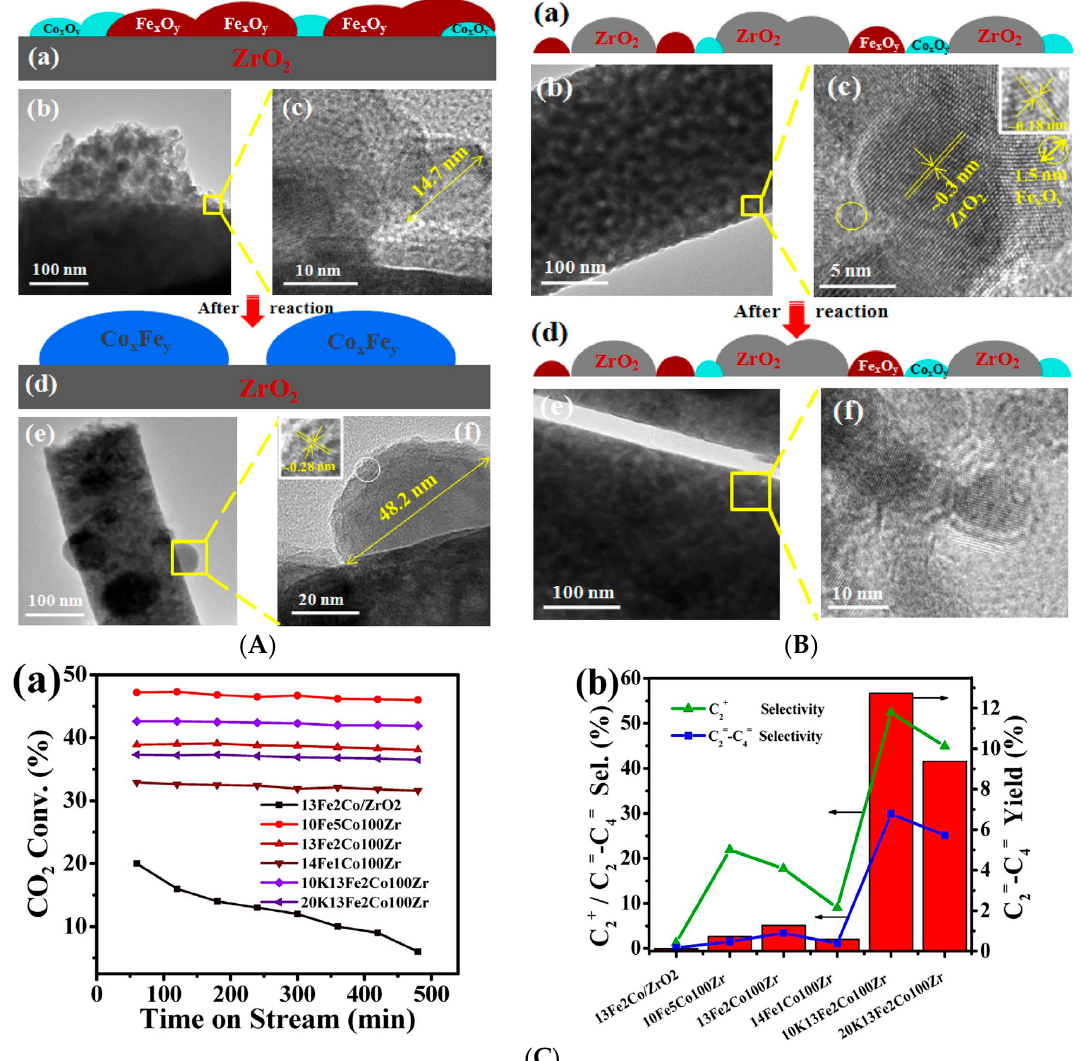
Figure 4. ( A ) ( a – f ) Schematic illustration of the metal distribution and TEM images of the 13Fe2Co/ZrO 2 -supported catalyst precursor ( a – c ) and the spent catalyst ( d – f ). ( B ) ( a – f ) Schematic illustration of the metal distribution and TEM images of the 13Fe2Co100Zr polymetallic oxide fiber catalyst ( a – c ) and the spent catalyst ( d – f ). ( C ) CO 2 conversion ( a ) and the C 2+ /C 2= –C 4= selectivity and C 2= –C 4= yield ( b ) over different catalysts after 8 h TOS (testing conditions: H 2 /CO 2 molar ratio = 3/1, GHSV = 7200 ml g − 1 h − 1 , P = 3 MPa, T = 673 K). Adapted with permission from ref. [56]. Copyright 2019 Elsevier.